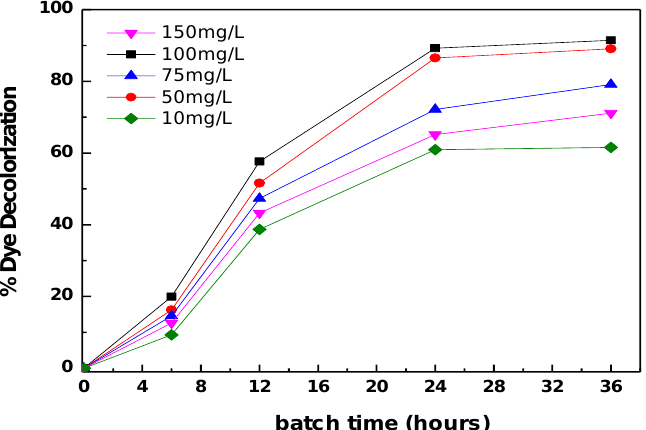
Figure 4. Congo red dye decolorization in percentages at pH 7 by incubation time.